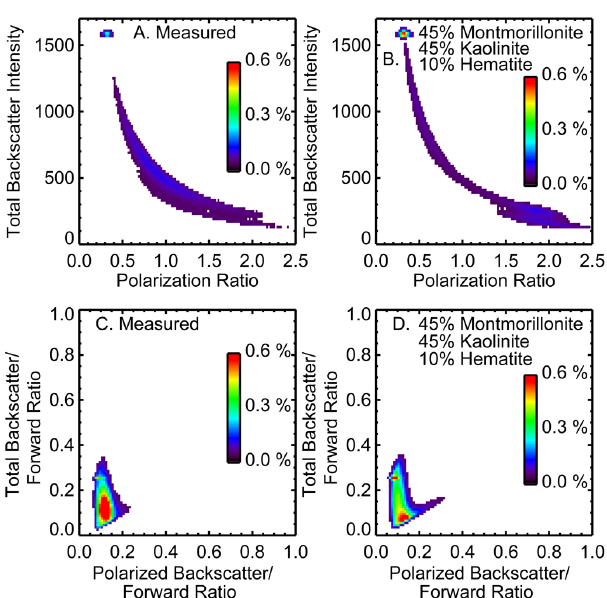
Fig. 11. The optical signature of measured Arizona test dust sam- ple and the composite signature generated using montmorillonite, kaolinte and hematite data are shown in (a) and (b), respectively.